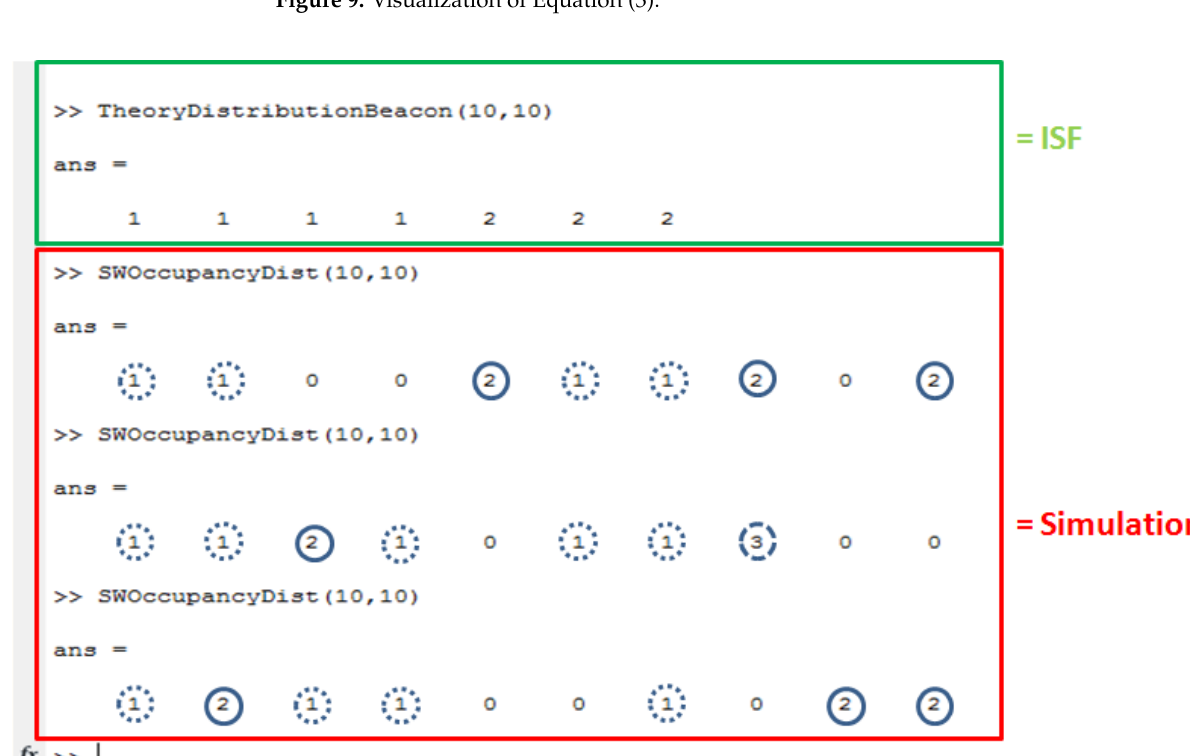
Figure 9. Visualization of Equation (3).